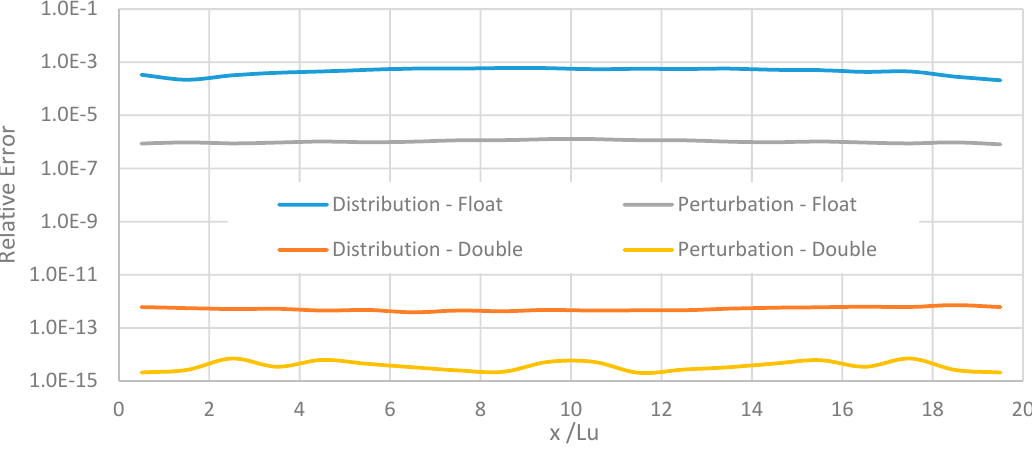
Figure 3. The relative error of the flow between plates for different calculation schemes and precisions for a body-force of 10 ´ 6 .